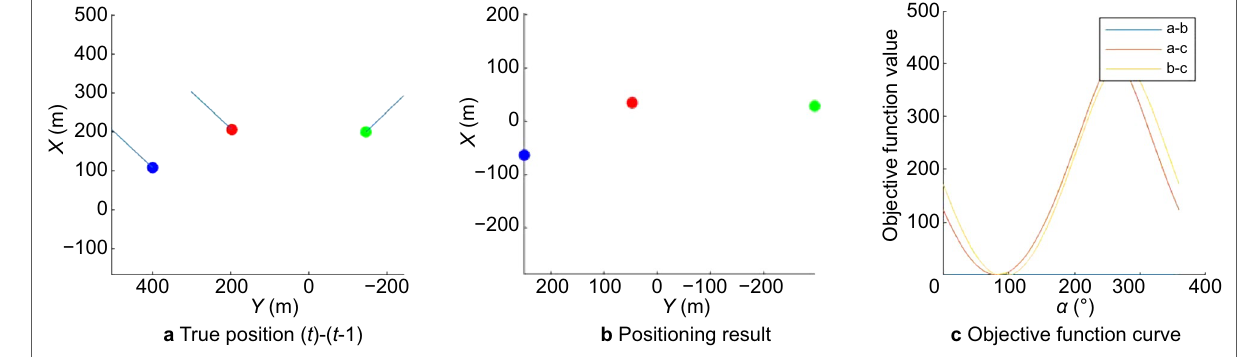
Fig. 10 Cross-line formation scenario, simulation results at time t = 1